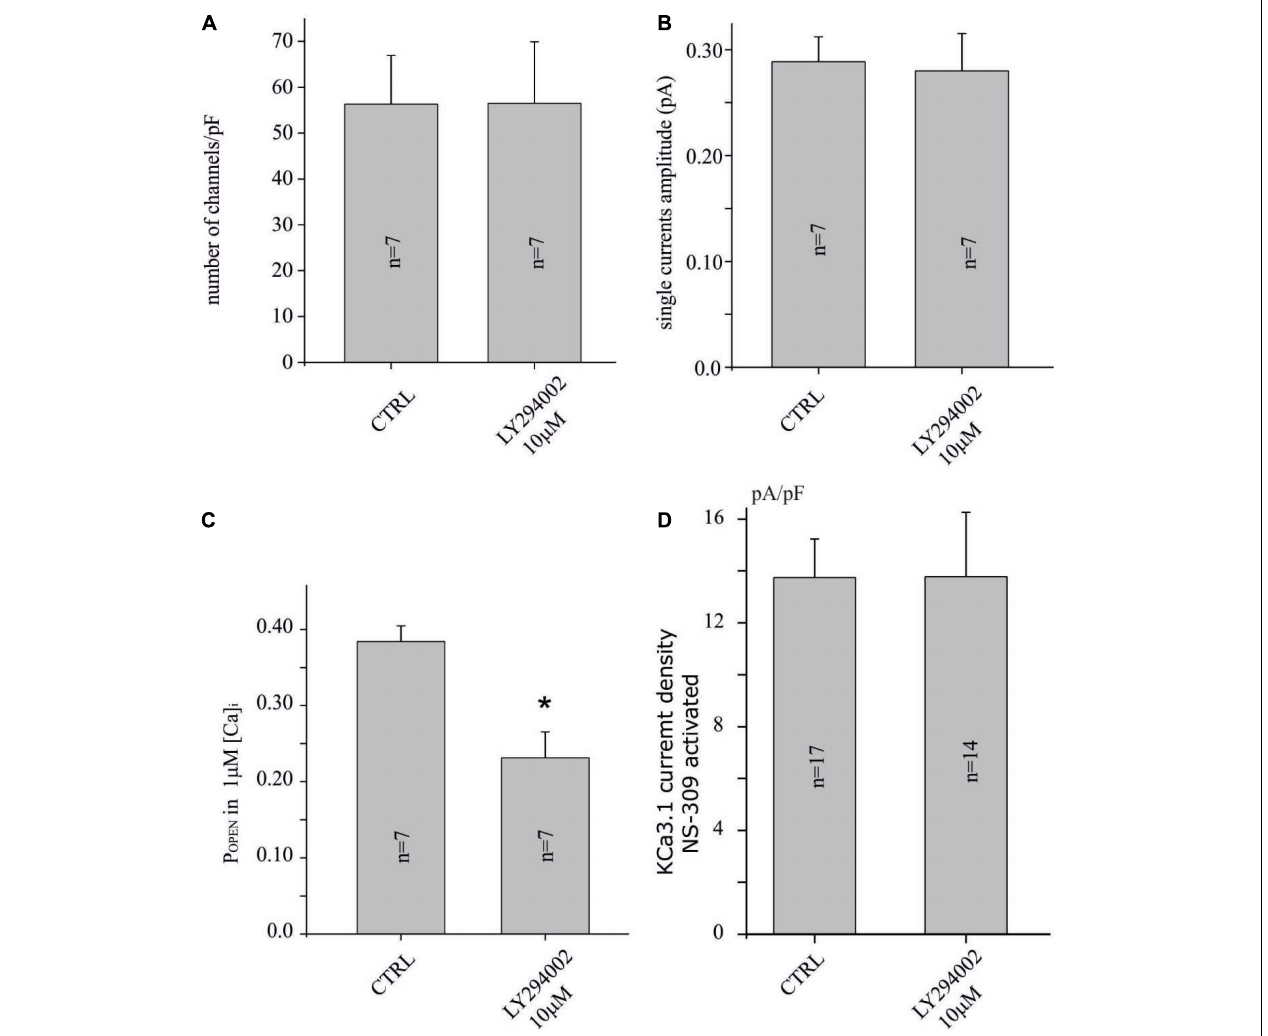
FIGURE 3 | LY294002 reduces the P OPEN of the KCa3.1 channel, but not the number and the amplitude of the single-channel current. (A) Bar plot of the number of channels (channels/pF) estimated by noise analysis in CTRL and in cells treated with LY294002 10 µ M, 15 min (refer to the “Materials and methods” section and text for details). (B) Bar plot of the single-channel current (pA) estimated by noise analysis in CTRL and in cells treated with 10 µ M LY294002, 15 min. (C) Bar plot of P OPEN with 1 µ M calcium in the pipette in CTRL condition and after treatment with 10 µ M LY294002, 15 min. (D) Bar plot of KCa3.1 current density estimated after KCO (3 µ M, NS-309) application in U251 cells in CTRL condition and treated with 10 µ M LY294002, 15 min (* p <